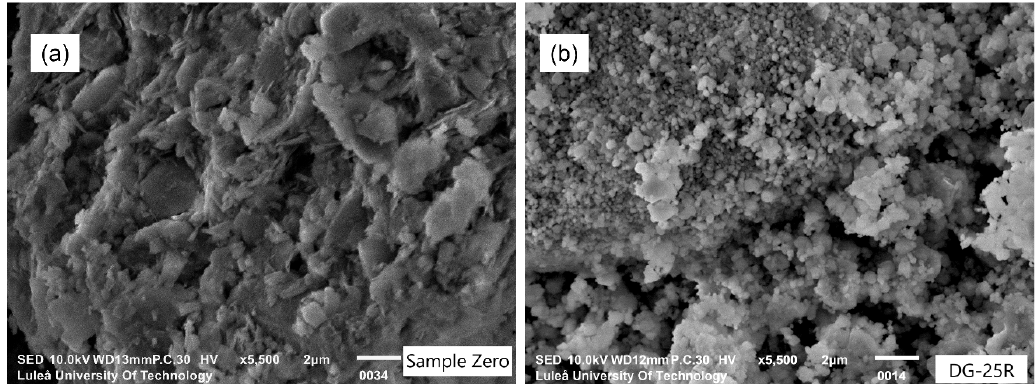
Figure 4. SEM-SE micrographs of a Swedish raw clay: ( a ) sample S0; ( b ) sample DG-25R.